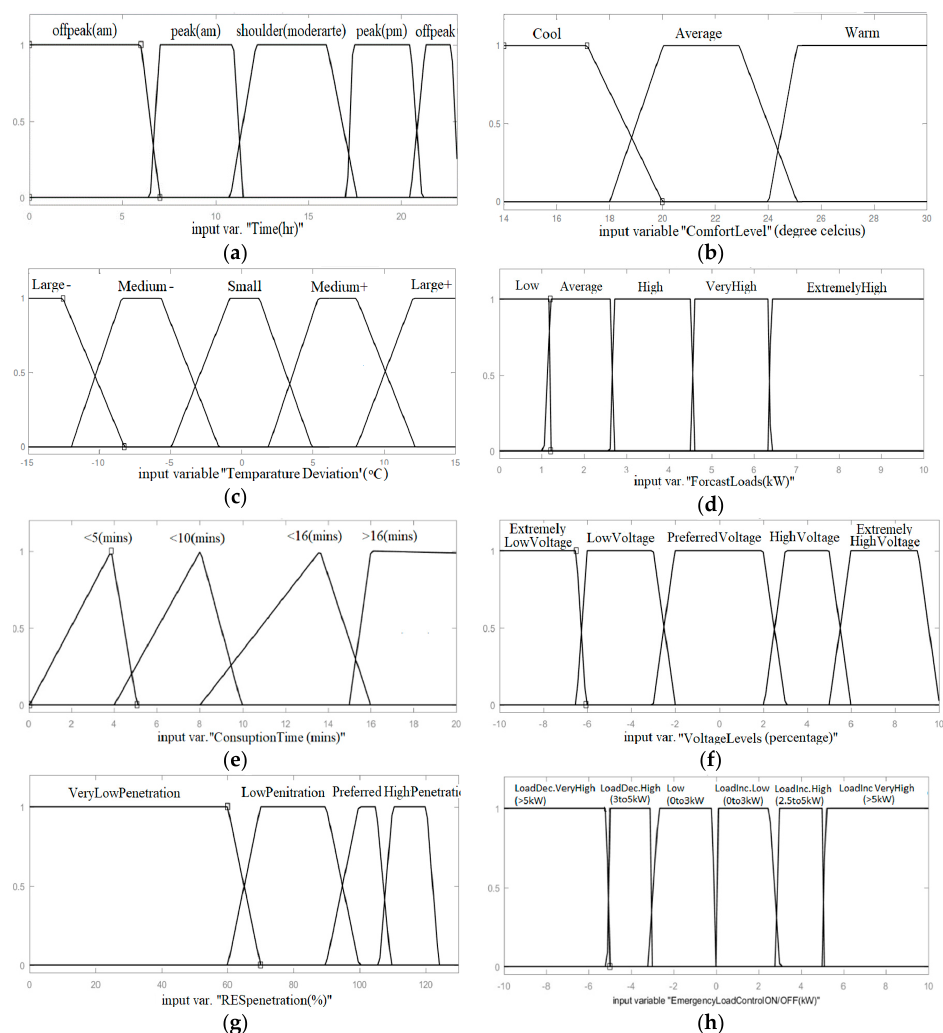
Figure 11. (Left–Right; Top–Bottom): Fuzzy input membership function for ( a ) time; ( b ) comfort preference; ( c ) temperature deviation; ( d ) forecasted demand; ( e ) consumption time; ( f ) local voltage level; ( g ) renewable energy sources (RES)_penetration; and ( h ) utility load control.